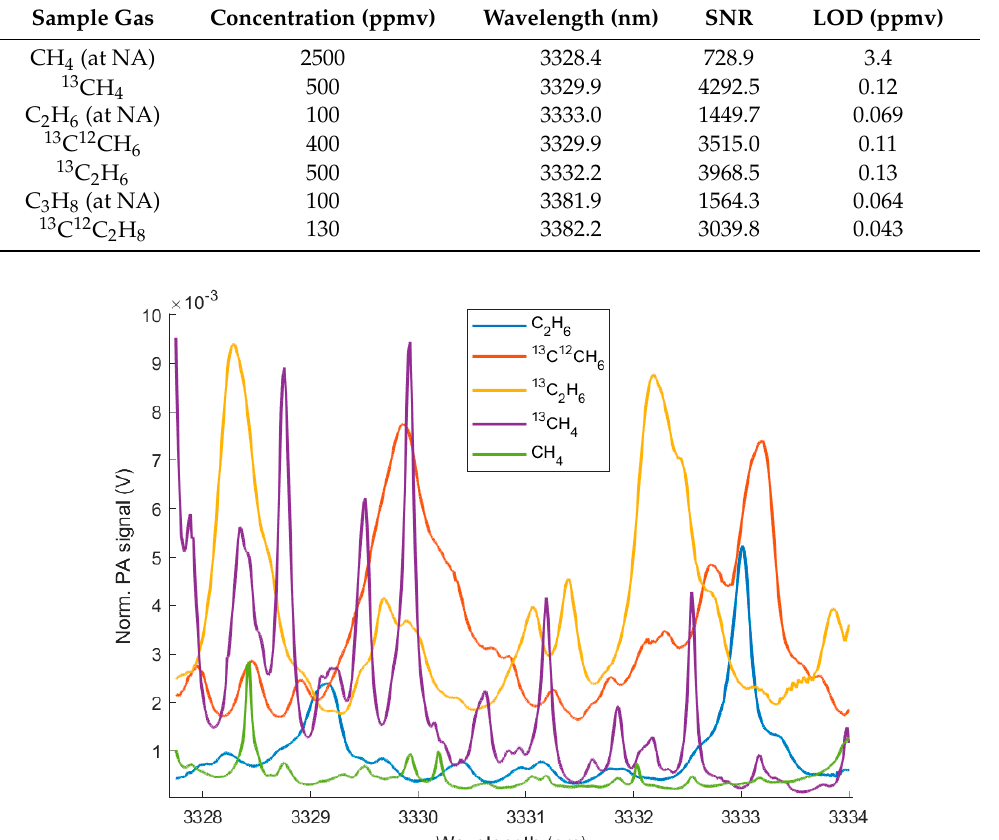
Figure 4. PA spectra measured with interband cascade lasers (ICL) 1541 of sample gases with concentrations according to Table 2.